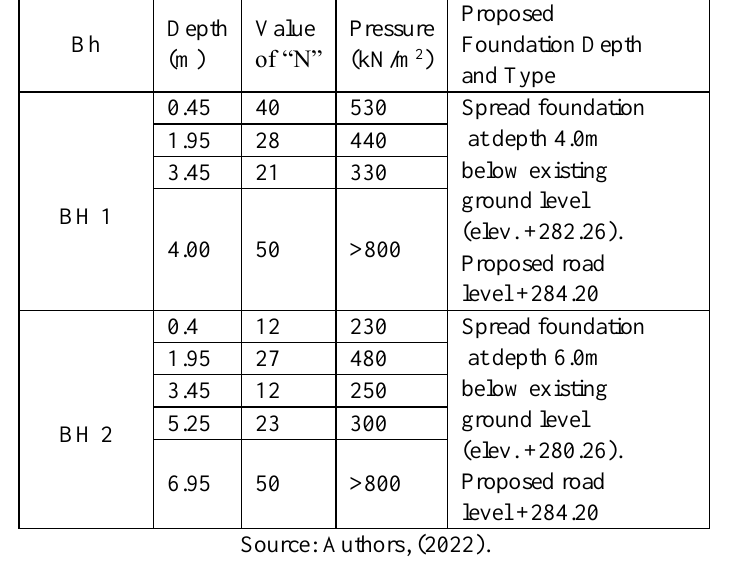
Table 1: SPT Results and Foundation Recommendation (based on 2Nos. Exploratory boreholes drilled at the site).